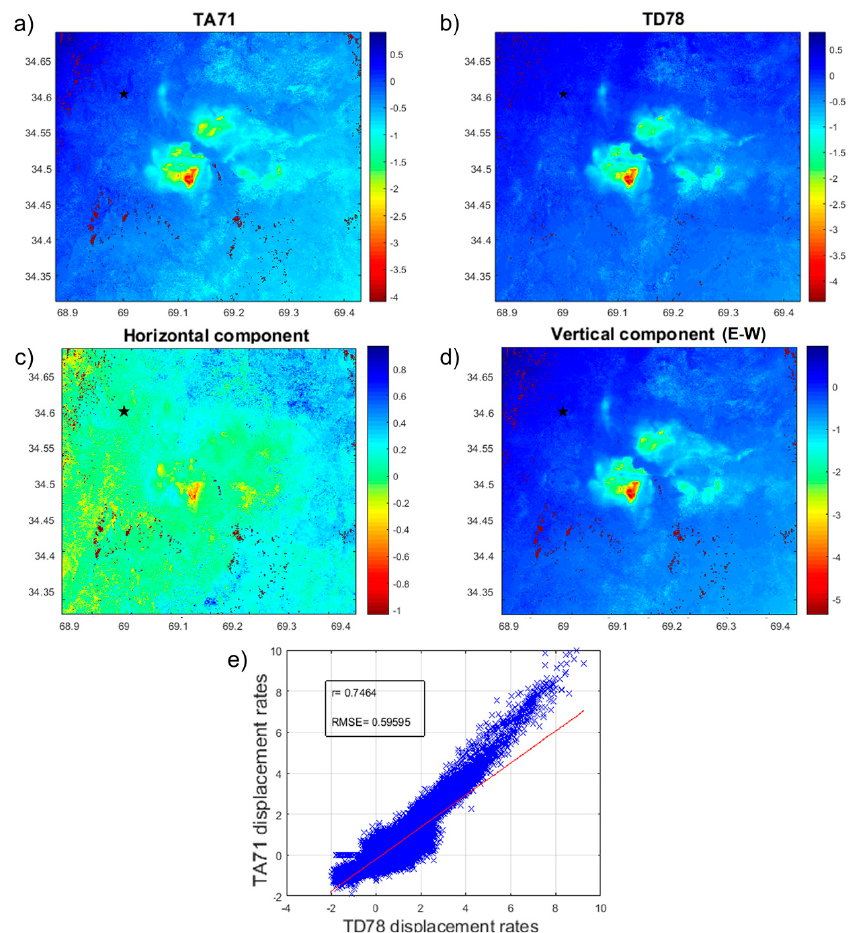
Figure 4. Mean annual Line-of-Sight (LOS) velocity maps from Sentinel-1 ( a ) ascending and ( b ) descending tracks; mean deformation velocity rates for ( c ) vertical and ( d ) horizontal components. The black star denotes the location of a reference point. ( e ) Correlation between LOS mean annual displacement rates estimated from two tracks. Blue dots denote LOS measurements whereas red solid line indicates linear fitting. Unit: cm/year.